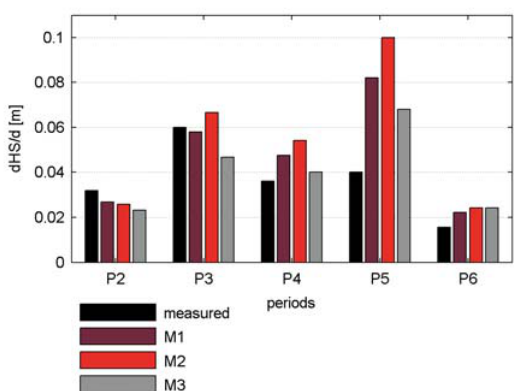
Fig. 7. Daily ablation rates averaged over the respective periods (measured and modeled). Modeled ablation rates are either calcu- lated driven by wind velocity fields obtained from ARPS and with (M1) or without stability correction (M2) or driven by wind speed obtained from a single weather station and stability correction